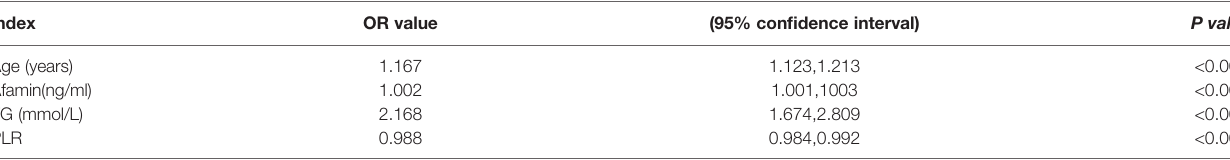
TABLE 2 | Risk factors associated with gestational diabetes mellitus: multi-factor logistic regression analysis.